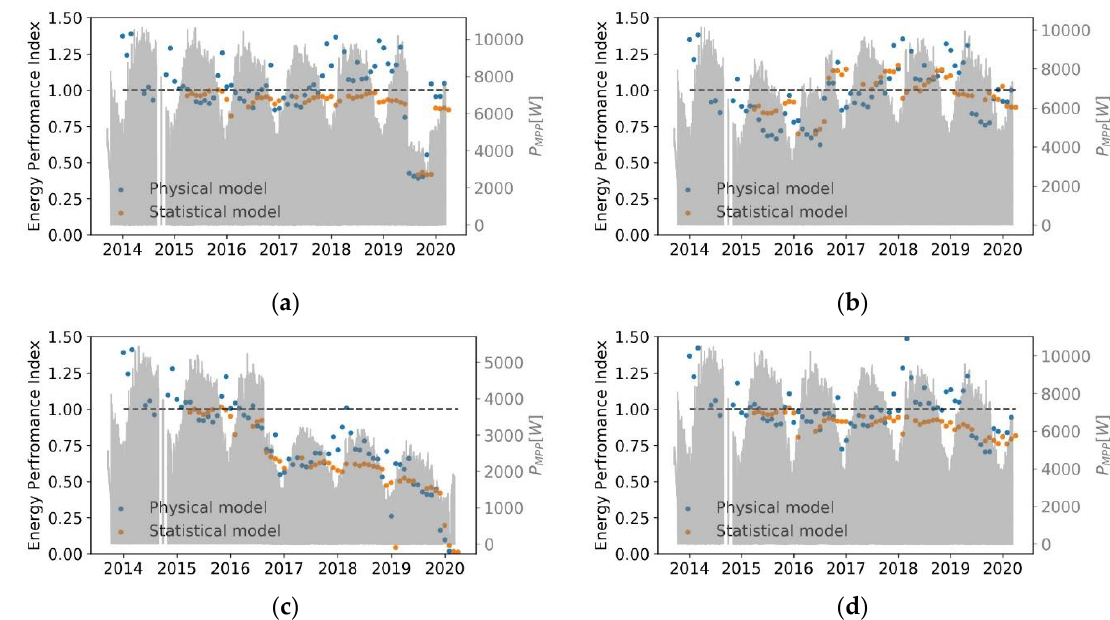
Figure 14. Measured P MPP values together with the EPI calculated using physical and statistical models for MPPTs: ( a ) “1U03-T1”, ( b ) “1U09-T1”, ( c ) “1U09-T2”, and ( d ) “1U06-T1”.